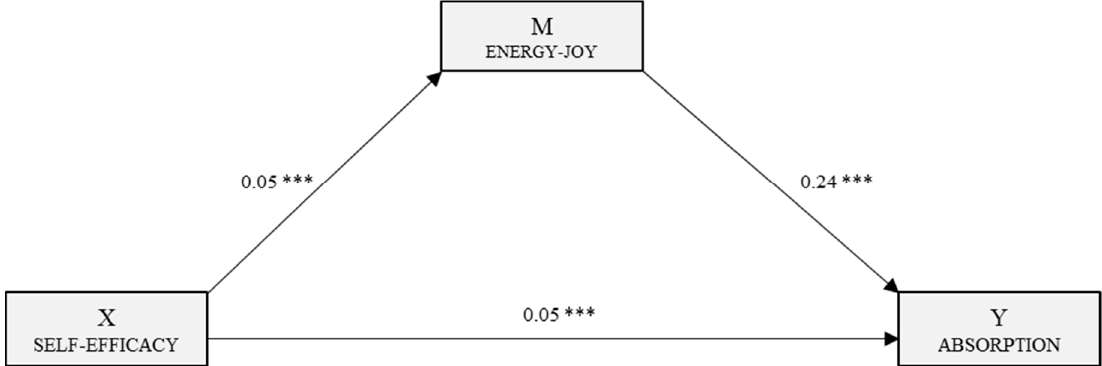
Figure 3. Simple mediation model of perceived stress in the relationship between self ‐ efficacy and the engagement dimension, Absorption. *** p < 0.001.